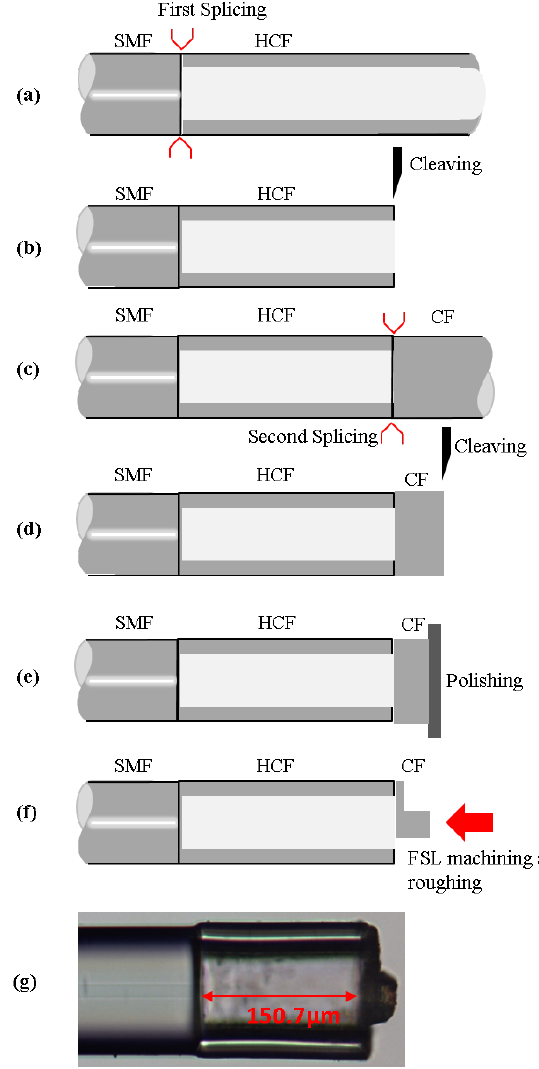
Figure 2: Fabrication procedure for the vibration sensor (a)–(f)